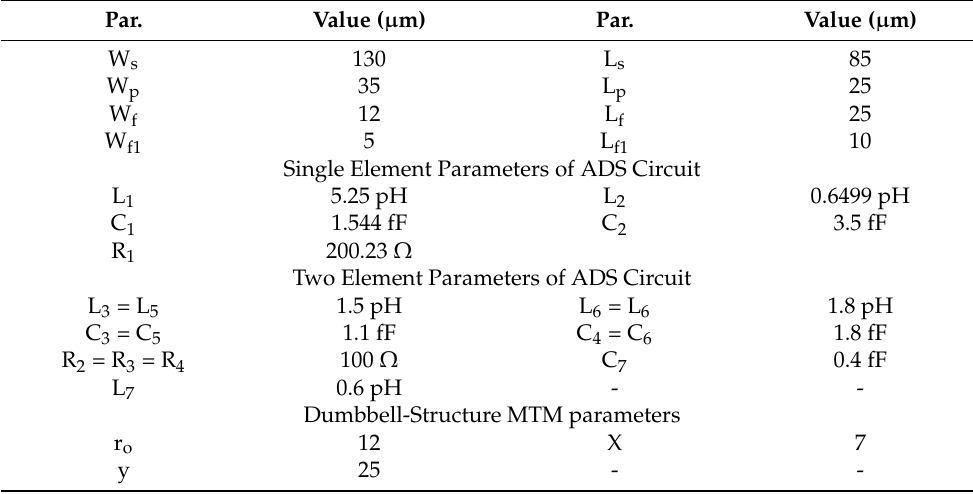
Figure 3. Schematic of the graphene plasmonic patch antenna .